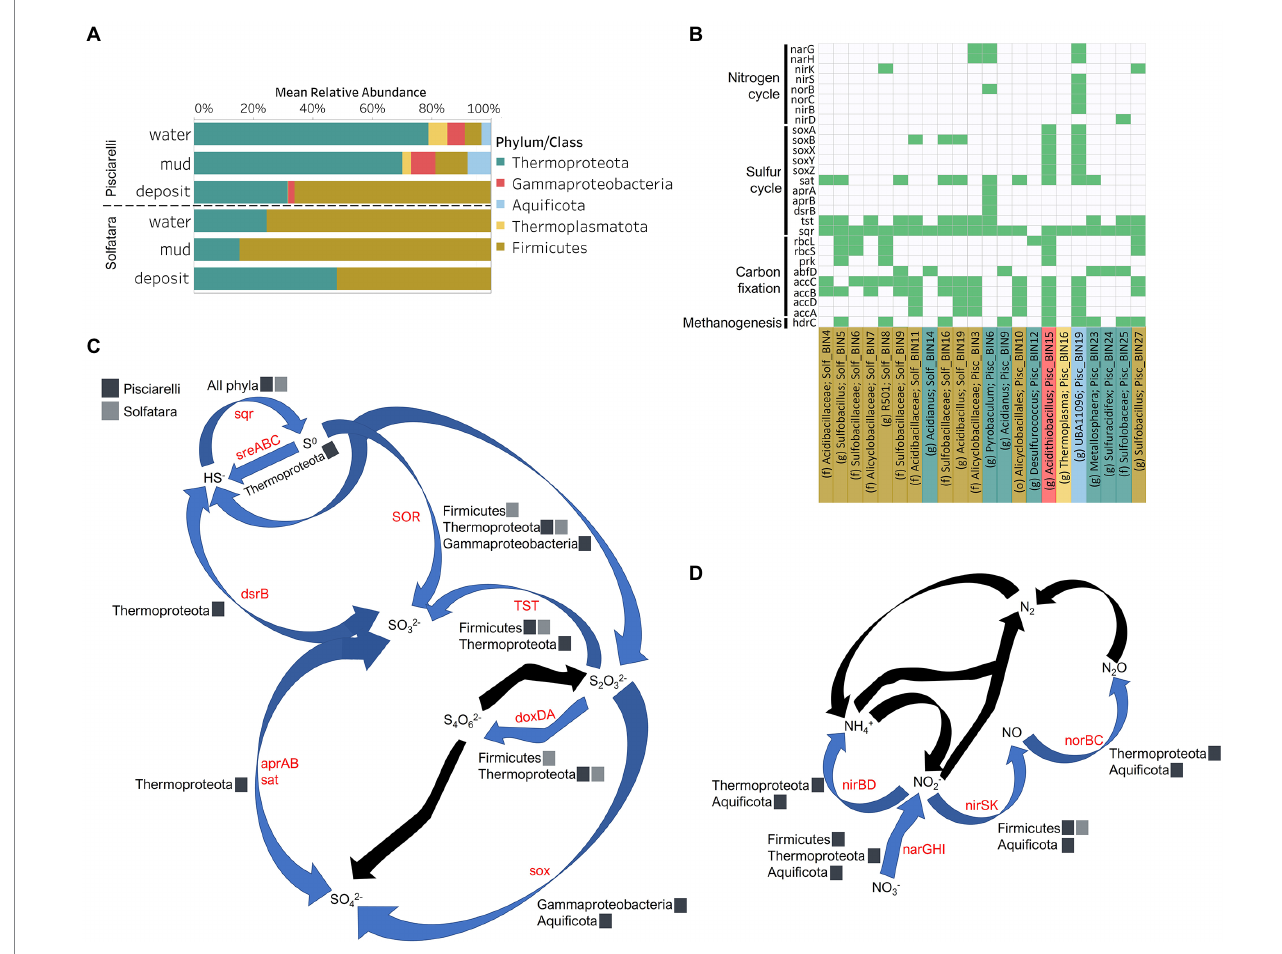
FIGURE 8 Taxonomy and functional potential of Metagenome Assembled Genomes (MAGs) in Solfatara-Pisciarelli hydrothermal systems. (A) Normalized mean (relative) abundance of sequences assigned to each MAG at the phylum/class level in each substrate. (B) Tile plot of selected marker genes ( y -axis) present in each MAG ( x -axis). Green color represents presence of gene in MAG. MAGs on the x -axis are colored based on phylum/class. Each MAG is labeled either by genus level assignment (g) or by the lowest taxonomic level assigned (f; family and o; order) to the MAG. (C) Sulfur cycle and (D) Nitrogen cycle. Phyla/ Class from the different locations participating in each process are indicated. Gene participating in each process are indicated in red text. Black arrows denote processes that were not found in